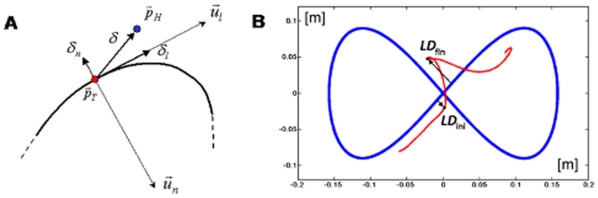
Tracking error and lateral deviation.
A: Decomposition of the tracking error into a longitudinal and normal component. : position vectors of the target and the hand, respectively; : longitudinal and normal unit-vectors, respectively. B: Characterization of a catch trial in terms of the initial and final values of the lateral deviation (LDini and LDfin, respectively).